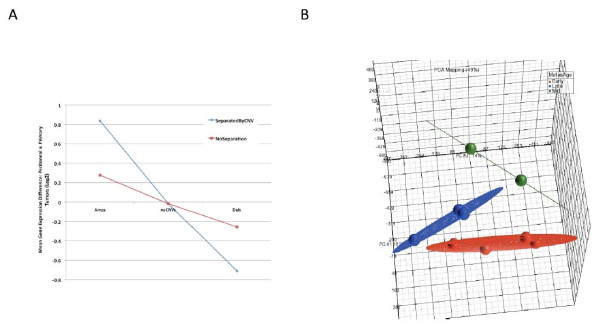
The effect of underlying copy number variations on gene expression differences between peritoneal and primary tumors. A. Greater than 2000 genes were used for the analysis. When gene expression data is analyzed by groups of patients containing either amplification (amp), or deletion (del) CNV, the gene expression differences are more significant (SeparatedByCNV). When patients are all analyzed together (NoSeparation), without separating them based on underlying CNVs, the gene expression differences are significantly decreased. As expected, the average gene expression differences between primary and peritoneum in genes outside of CNVs (noCNVs) is near zero. Gene expression data from patients without CNVs do not change. B. For each gene in a patient's primary/metastatic pair, the primary tumor expression value was subtracted from the metastatic expression value. The paired gene expression differences for all genes in each patient were then subjected to principal components analysis in Partek.